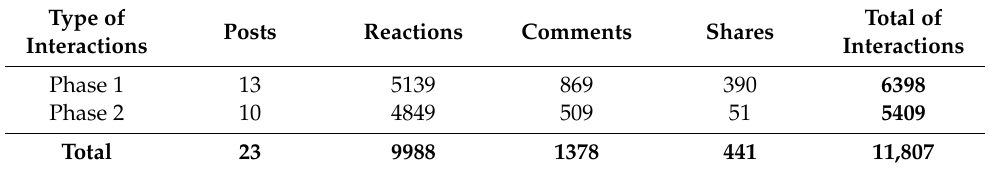
Figure 8. The interactions rate between two phases in the influencer marketing campaign from 24 Table 2. Total of interactions for each phase. Type of Table 3. Sentiments of posts and comments in two phases.